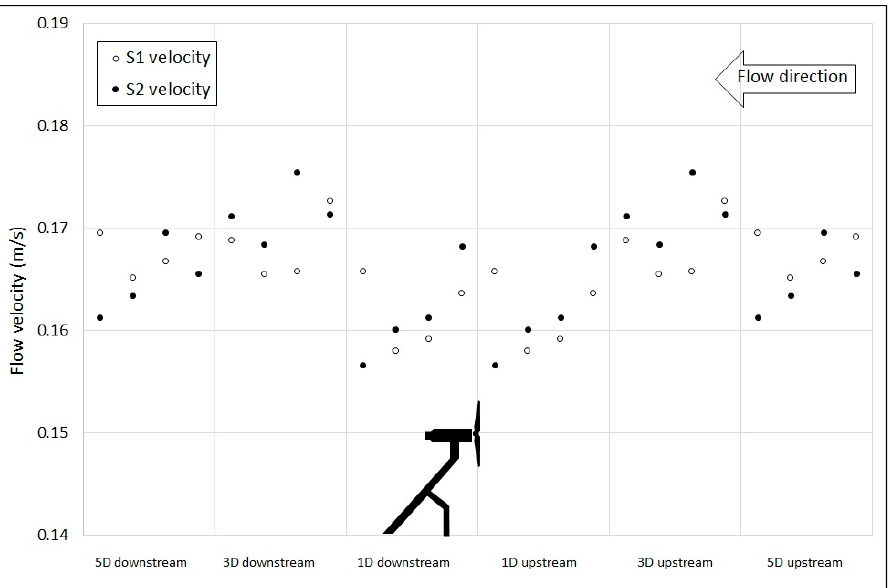
Figure 7. Resampled hub height velocity recorded at 1D, 3D and 5D upstream and 1D, 3D and 5D downstream of turbine mounted on S1 and S2 support structures (1024 samples at 25 Hz per point).